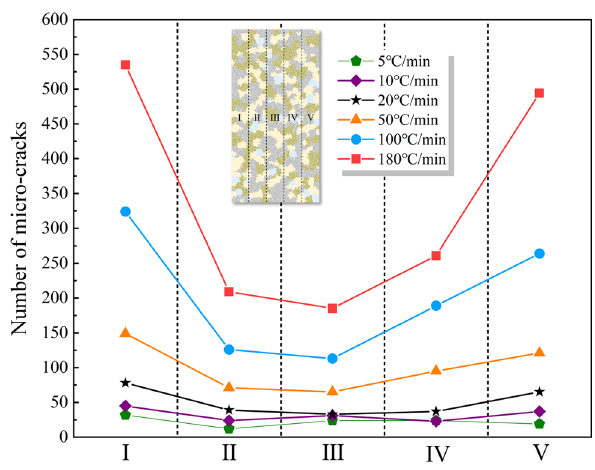
Fig. 13 Number of microcracks in different